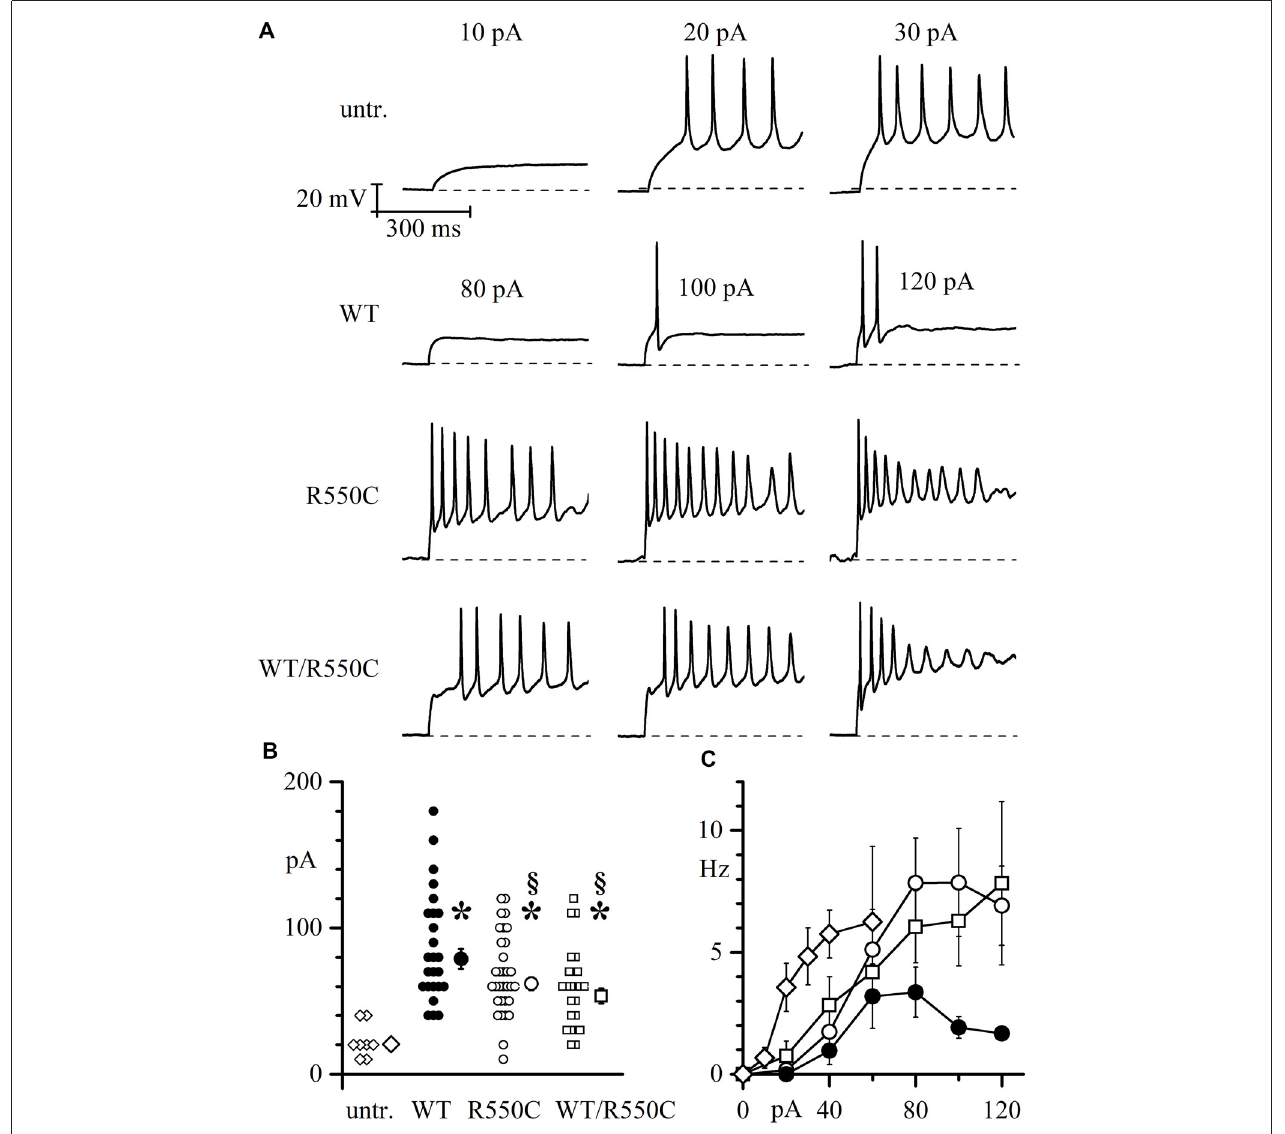
FIGURE 5 | Membrane excitability of neonatal rat cortical neurons (NRCNs) increases in cells expressing mutant vs. WT channels. (A) The top three panels show representative voltage traces recorded upon injection of 10, 20 and 30 pA current steps applied from cells held at − 70 mV (dashed lines) in untransfected cortical neurons. The remaining panels show traces recorded upon injection of 80, 100 and 120 pA current steps in cortical neurons transfected with either WT, R550C or WT/R550C hHCN4, as indicated. Time and voltage scales apply to all panels. (B) Plot of the current necessary to trigger the first action potential (current threshold) in untransfected (open diamonds), WT (filled circles), R550C (open circles) and WT/R550C-transfected neurons (open squares). Shown are all recorded data and mean ± SEM values (in pA: untransfected: 22.5 ± 4.12, n = 8; WT: 86.8 ± 7.5, n = 25; R550C: 68.1 ± 4.9, n = 32; WT/R550C: 58.8 ± 5.6, n = 24; ∗ p < 0.05 relative to untransfected; § p < 0.05 relative to WT). (C) Plot of the mean firing rate, measured during the first 500 ms, as a function of the current step injected in untransfected neurons or neurons transfected with WT, R550C or WT/R550C channels (symbols as in B ).